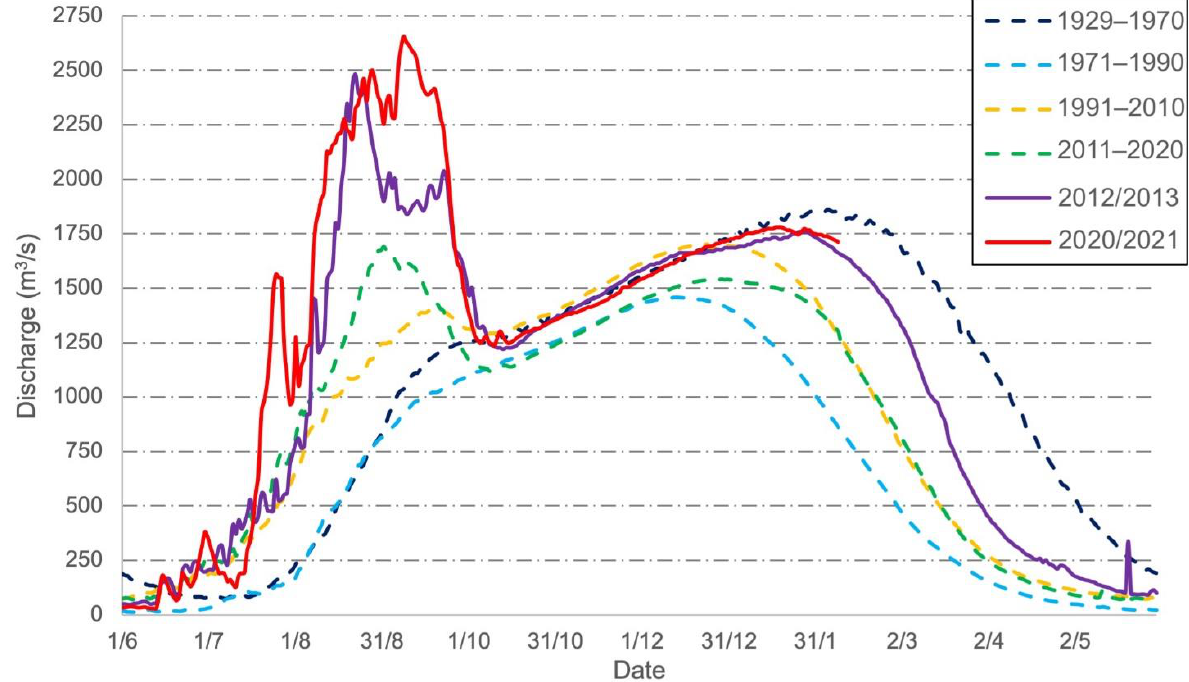
Figure 11. Mean intra-annual hydrographs (the hydrological year starts on 1 June and ends on 31 May) of Niger River in Niamey: the four hydrological periods (1929–1970, 1971–1990, 1991–2010, and 2011–2020) and the catastrophic years 2012 and 2020.